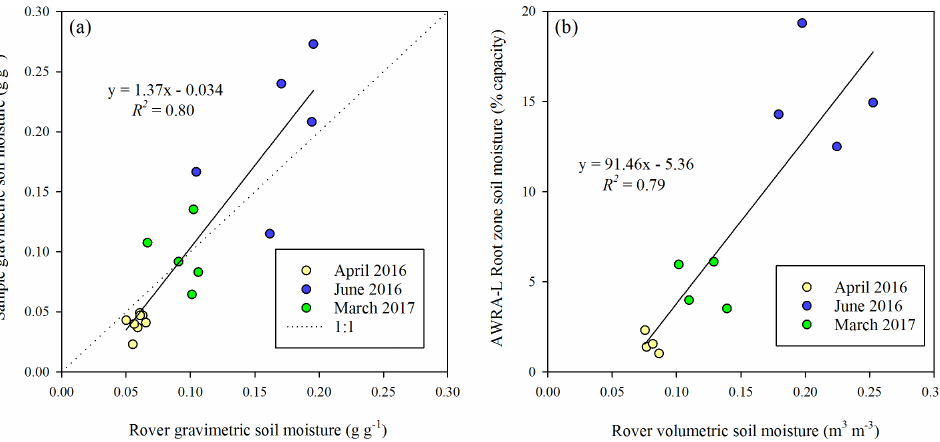
Figure 9. Intensive rover survey gravimetric soil moisture (1km resolution) versus point sample gravimetric soil moisture (a) and intensive rover survey soil moisture (up-scaled to 5km resolution) versus AWRA-L root zone soil moisture (5km